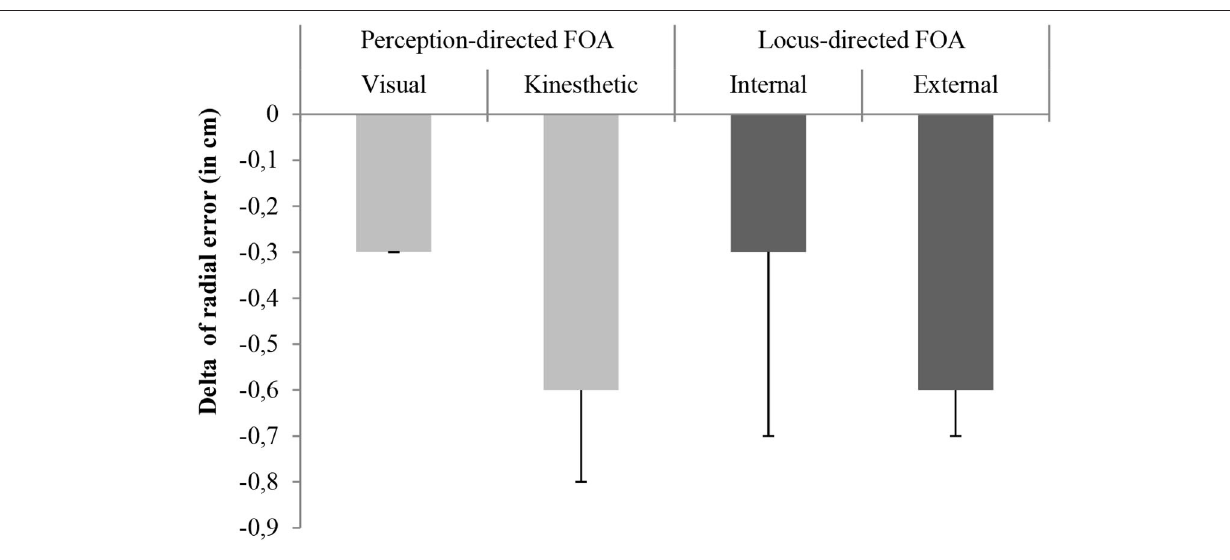
p = 0.08, f = 0.33, 1 − β = 0.97. Also, no significant differences between the locus-foci of attention F (1,31) = 0.40, p = 0.53, f